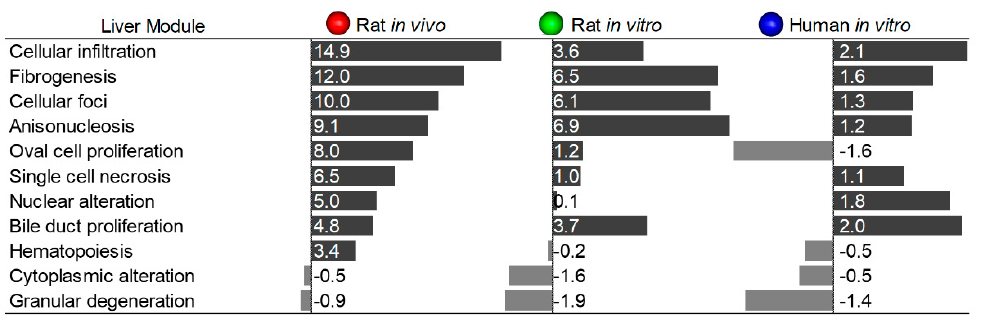
Figure 6. ( A ) Principal component analysis (PCA) using gene expression changes in liver samples obtained under four different conditions: low-dose 9-h (8 h for rat in vivo ), high-dose 9-h (8 h for rat in vivo ), low-dose 24-h, and high-dose 24-h treatment. The three enlarged spheres indicate the high-dose 24-h treatment for the three systems, and the ellipses highlight the clustering of conditions within each system. ( B ) PCA using 403 overlapping DEGs from Figure 2. ( C ) PCA using KEGG pathway activation for different conditions. ( D ) PCA using injury-module activation for different conditions. The orange ellipse highlights conditions where the modules indicate liver injury. ( E ) Graph showing relative liver-injury module activation for each system 24 h after high-dose treatment, ranked by the rat in vivo results.